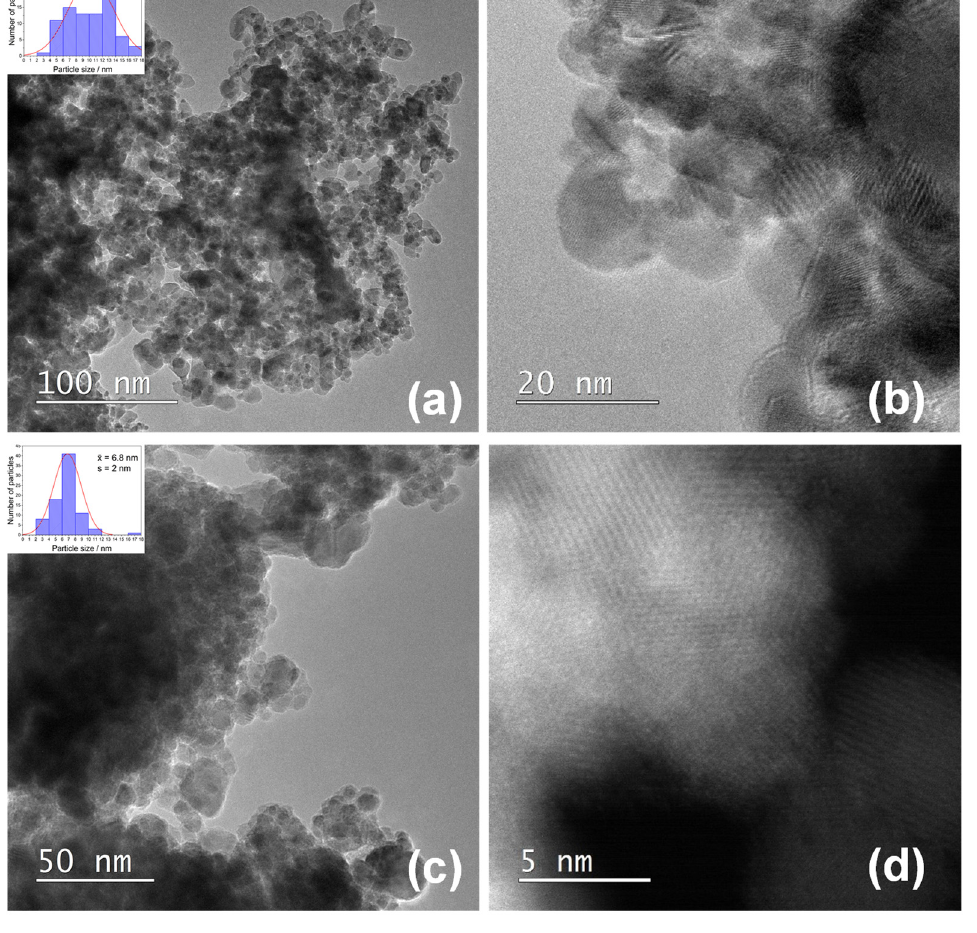
Figure 4. ( a ) STEM images and particle size distributions (inset) of samples SN-1 at low magnification and; ( b ) at high magnification; ( c ) STEM images and particle size distributions (inset) of samples SN-2 at low magnification and; ( d ) at high magnification.